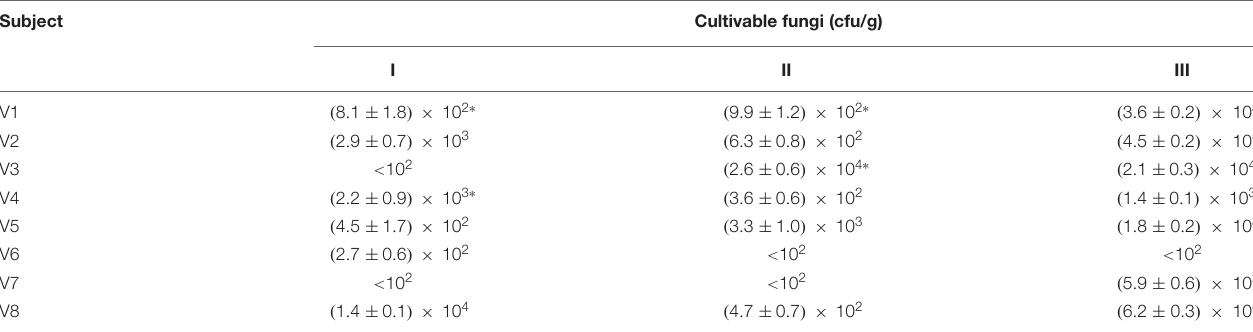
Values are means ± SD, n = 3. Within each row, for samples presenting detectable loads, ∗ indicate means that did not significantly differ (P > 0.05).